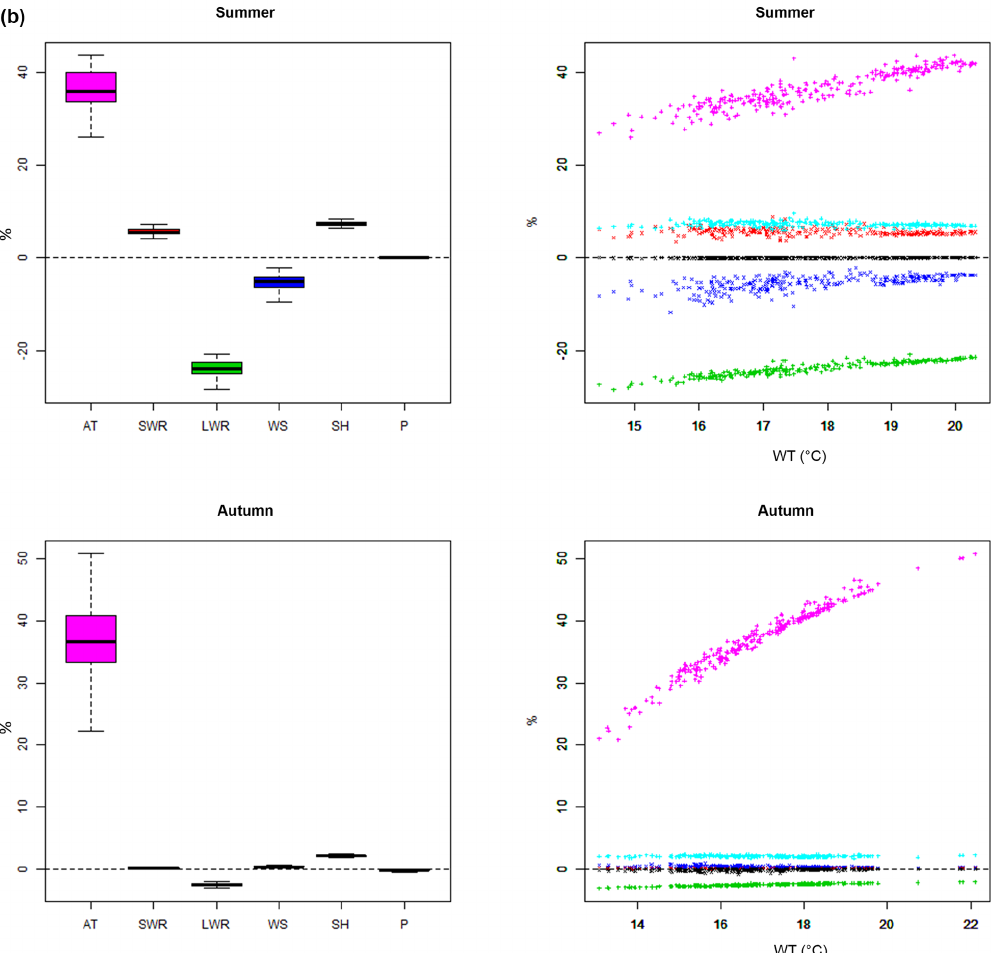
Figure 5. (a) Contributions of climate predictors to modelled WT (all seasons, winter, and spring): left-hand side, boxplots of percentage contributions of climate predictors to modelled WT values for all data points (except outliers); right-hand side, scatter plots of percentage contributions of climate predictors to modelled WT values against modelled WT values for all data points; colour coding for all plots: magenta, AT; red, SWR; green, LWR; dark blue, WS; cyan, SH; black, P . (b) Contributions of climate predictors to modelled WT (summer and autumn): left-hand side, boxplots of percentage contributions of climate predictors to modelled WT values for all data points (except outliers); right-hand side, scatter plots of percentage contributions of climate predictors to modelled WT values against modelled WT values for all data points; colour coding for all plots: magenta, AT; red, SWR; green, LWR; dark blue, WS; cyan, SH; black, P